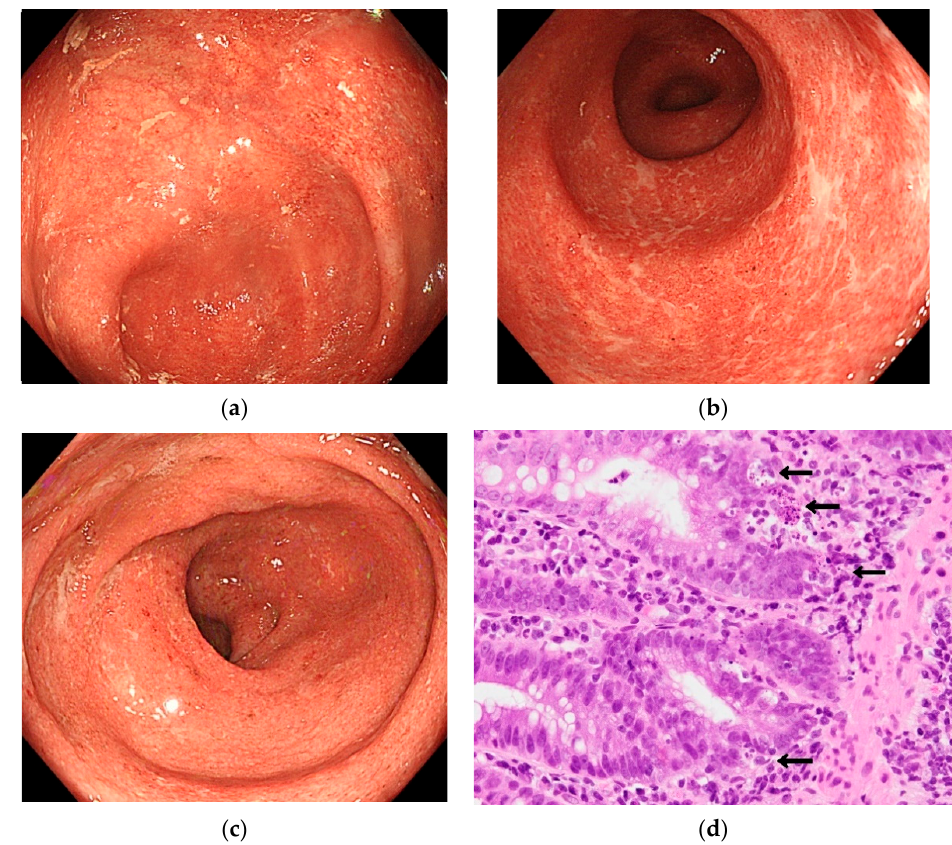
Figure 2. Endoscopic findings when the symptoms were most severe. The fine granular mucosa extends continuously from the rectum to the cecum. A hexagonal ulcer formation is also observed in part of the sigmoid colon. The degree of apoptosis (arrows) was the same as that of the prior colonoscopy. The apoptoses were 10 per 10 crypts: ( a ) cecum; ( b ) sigmoid colon; ( c ) rectum; ( d ) pathological image of sigmoid colon.